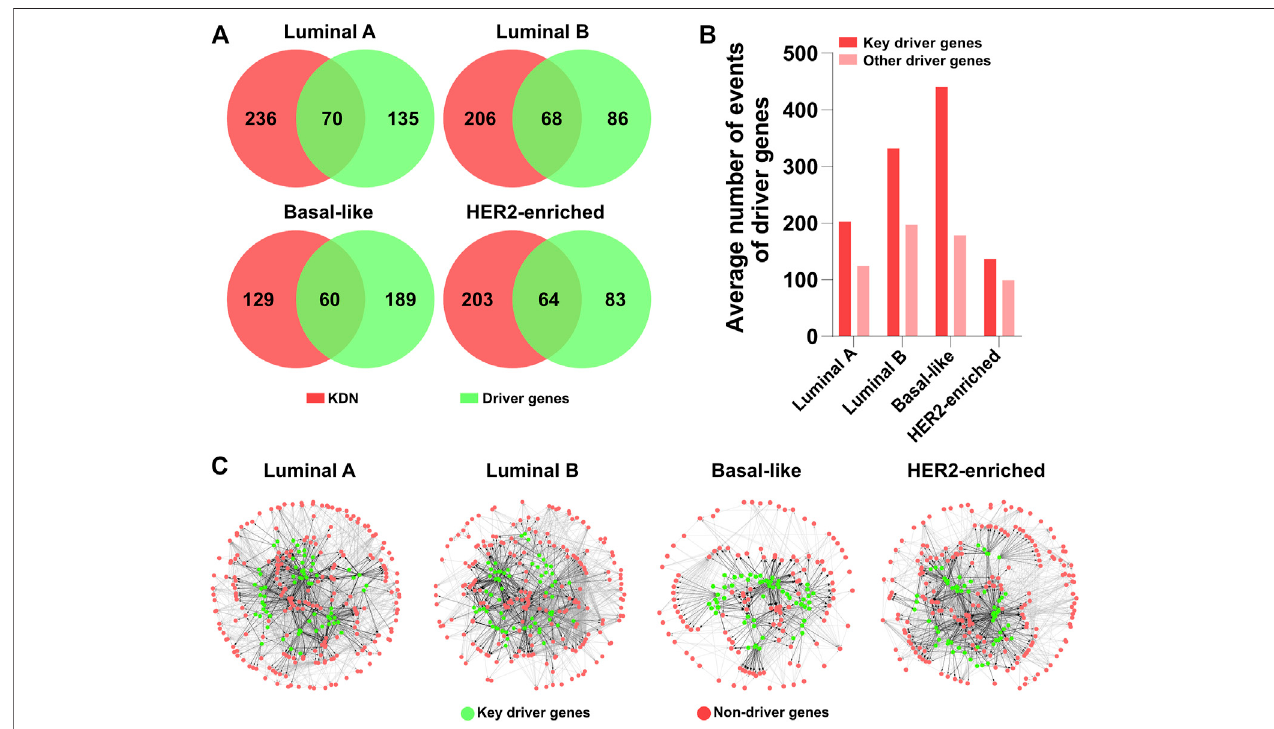
FIGURE 4 | Driver gene analysis. (A) Venn diagrams of the key genes and driver genes. (B) The average number of events of key driver genes and other driver genes. (C) KDN with driver genes in green color.